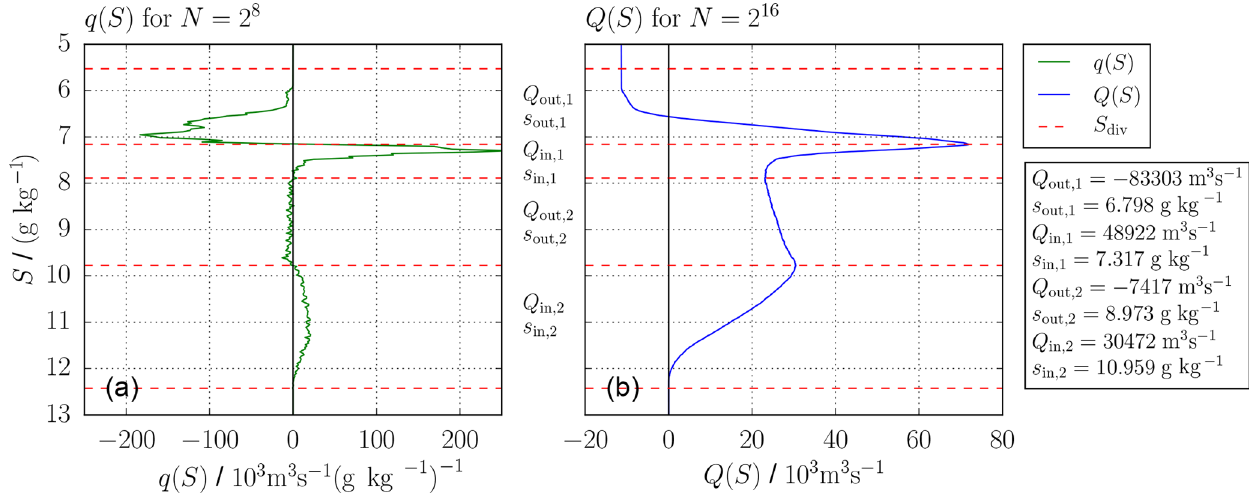
Figure 9. Cross section through Gotland Basin: profiles of q for N = 2 8 = 256 (a) and Q for N = 2 16 = 65536 (b) for the Gotland transect in 2002/2003. Five dividing salinities separate two inflows and two outflows. The corresponding TEF bulk values are listed on the